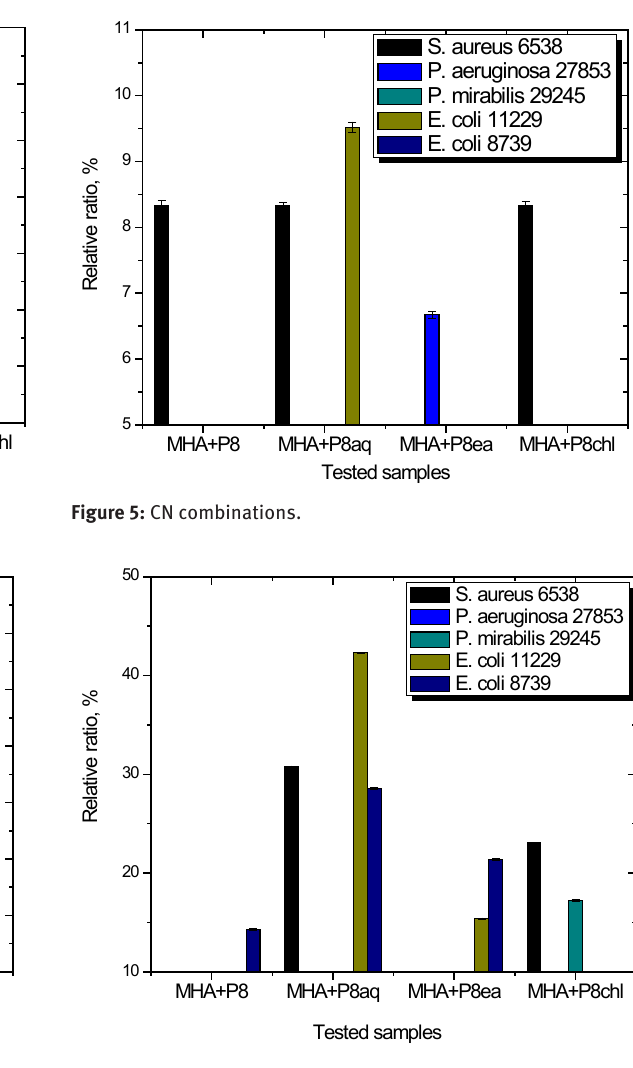
Figure 6: SXT combinations.